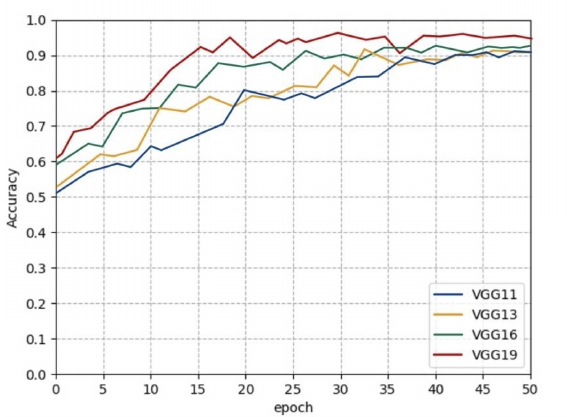
Figure 12. Experiment results of VGGNet series.